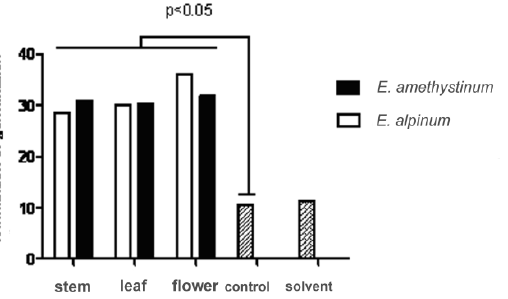
On clinical isolates of Candida spp. Presented values denote means ± SD. N = 3.